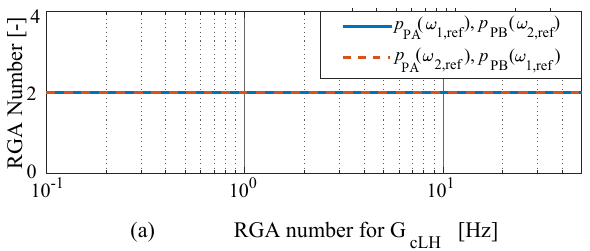
Figure 9: RGA numbers for diagonal and off-diagonal input/output pairings evaluated for the transfer function matrix G ( s ). LH